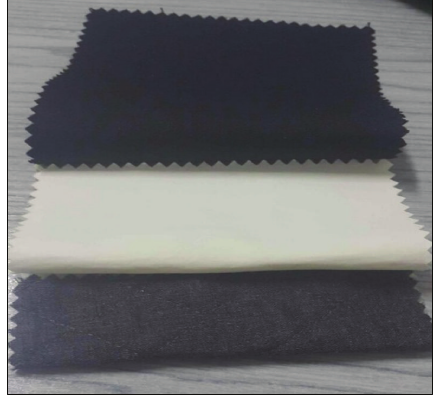
Figure 1: Assembly 1 with its three